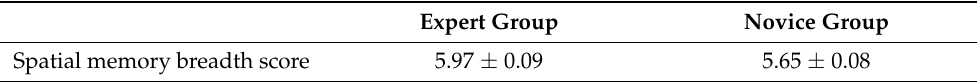
Table 3. Results of spatial working memory ability for map-recognition in non-orienteering scenes (M ± SD). Expert Group Novice Group Spatial memory breadth score 5.97 ± 0.09 5.65 ± 0.08